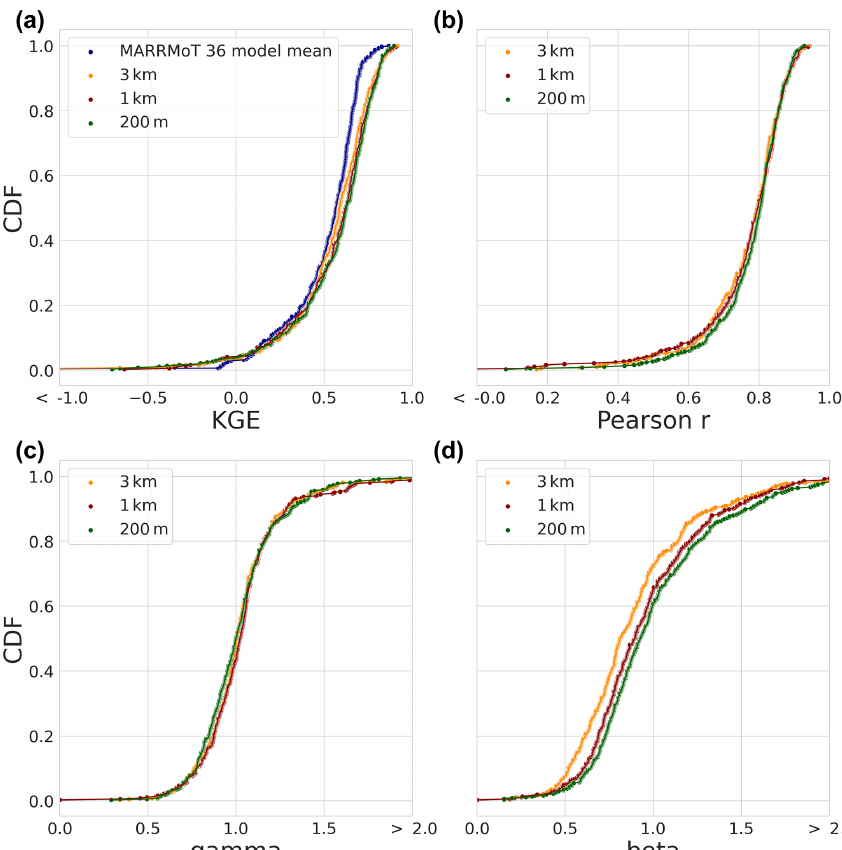
Figure 8. Evaluation period results. The CDF based on the modified KGE scores and its three individual components for the 454 selected basins. (a) The modified KGE score for the MARRMoT 36 mean results (blue), the 3km (yellow), 1km (red), and 200m (green) model instances. (b) The Pearson r correlation component. (c) The gamma variability component. (d) The beta bias component.